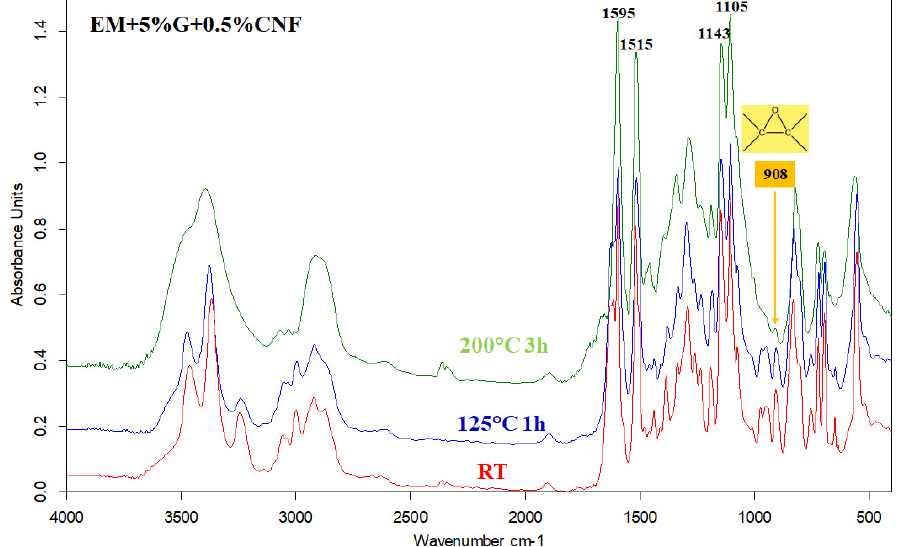
Figure 13. Comparison between FTIR curves of the EM+5%G+0.5%CNF sample before curing (RT) and after curing (125 °C 1 h and 200 °C 3 h). and after curing (125 ◦ C 1 h and 200 ◦ C 3